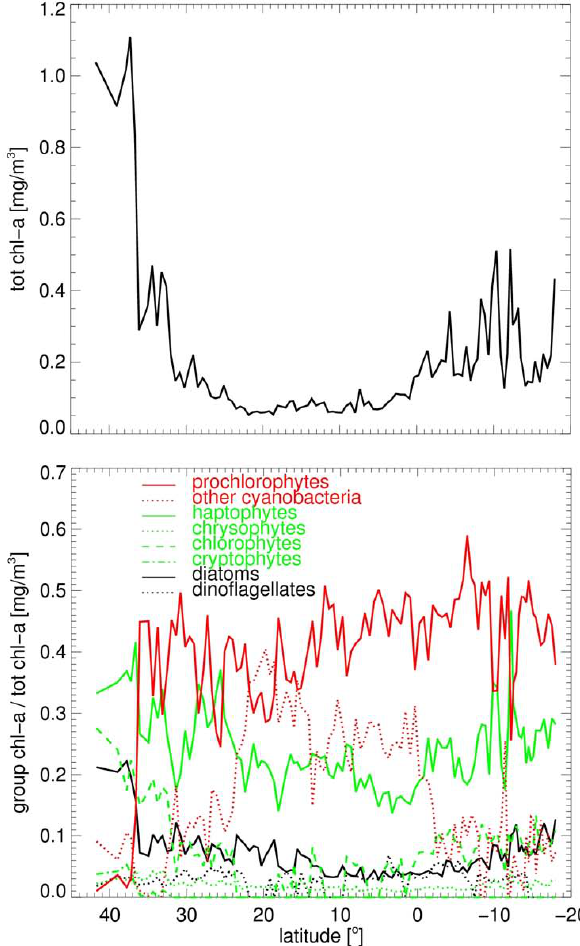
Fig. 2. Total Chl a concentration of main phytoplankton groups (mgm − 3 ) as derived from major pigment composition (upper panel); ratio of phytoplankton groups divided by the TChl a con- centration in correspondence to the latitude sampled (lower